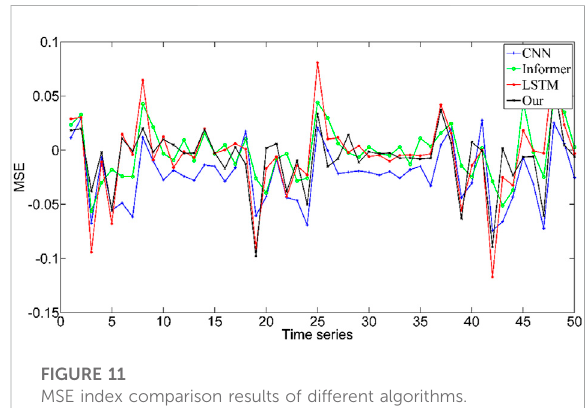
FIGURE 11 MSE index comparison results of different algorithms.